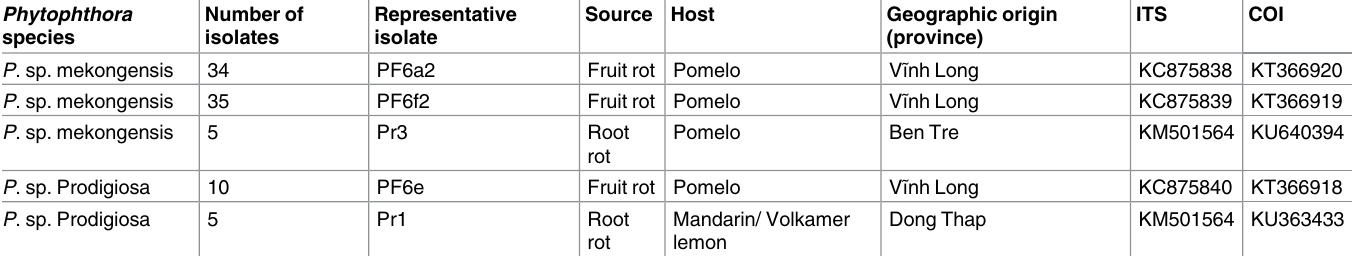
Table 1. Phytophthora species sampled in the Mekong River delta (Vietnam), source, host, location of recoveryand GenBank accession numbers of ITS and COI sequences of representative isolates. Phytophthora